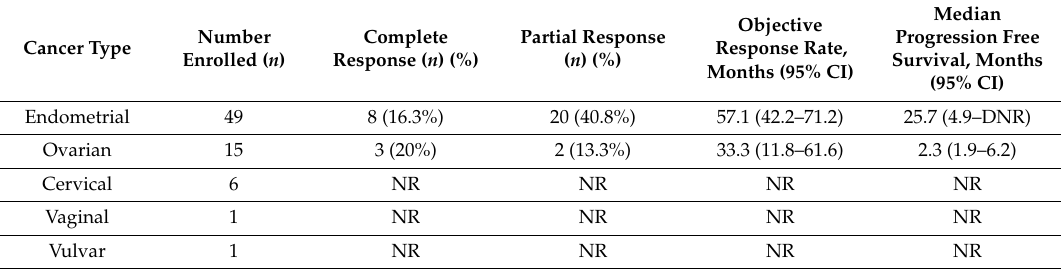
Table 4. Response to pembrolizumab among gynecologic cancer subtypes from the phase II KEYNOTE-158